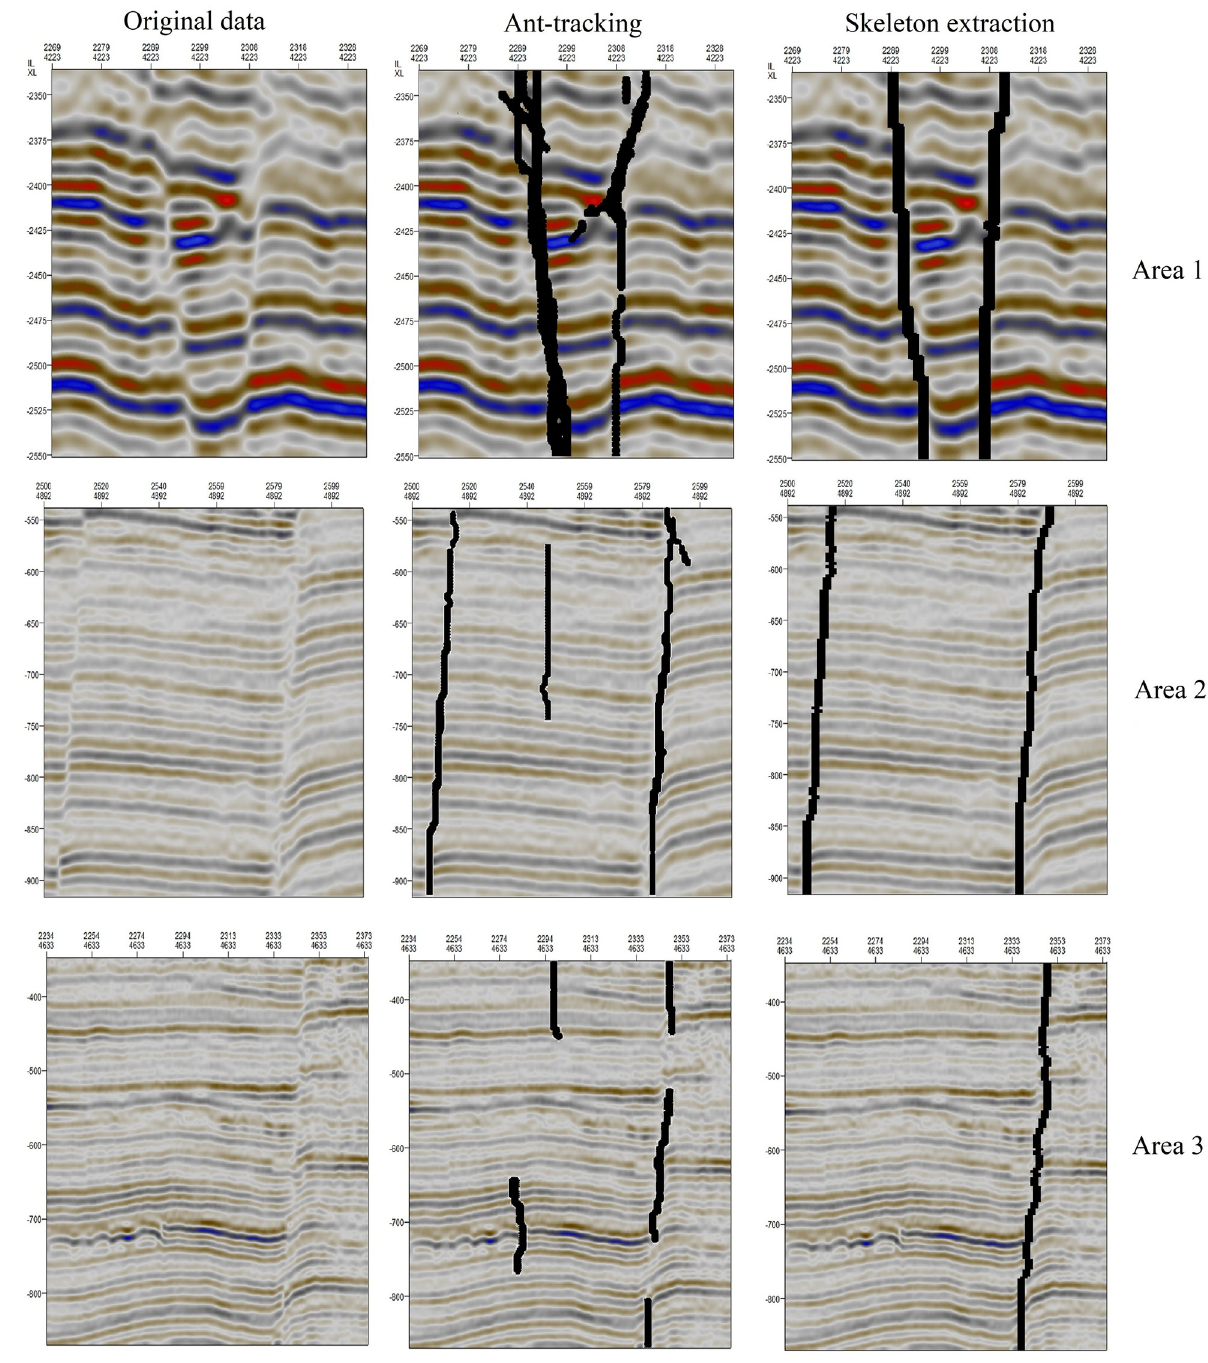
Fig 14. Comparison of ant tracking and skeleton